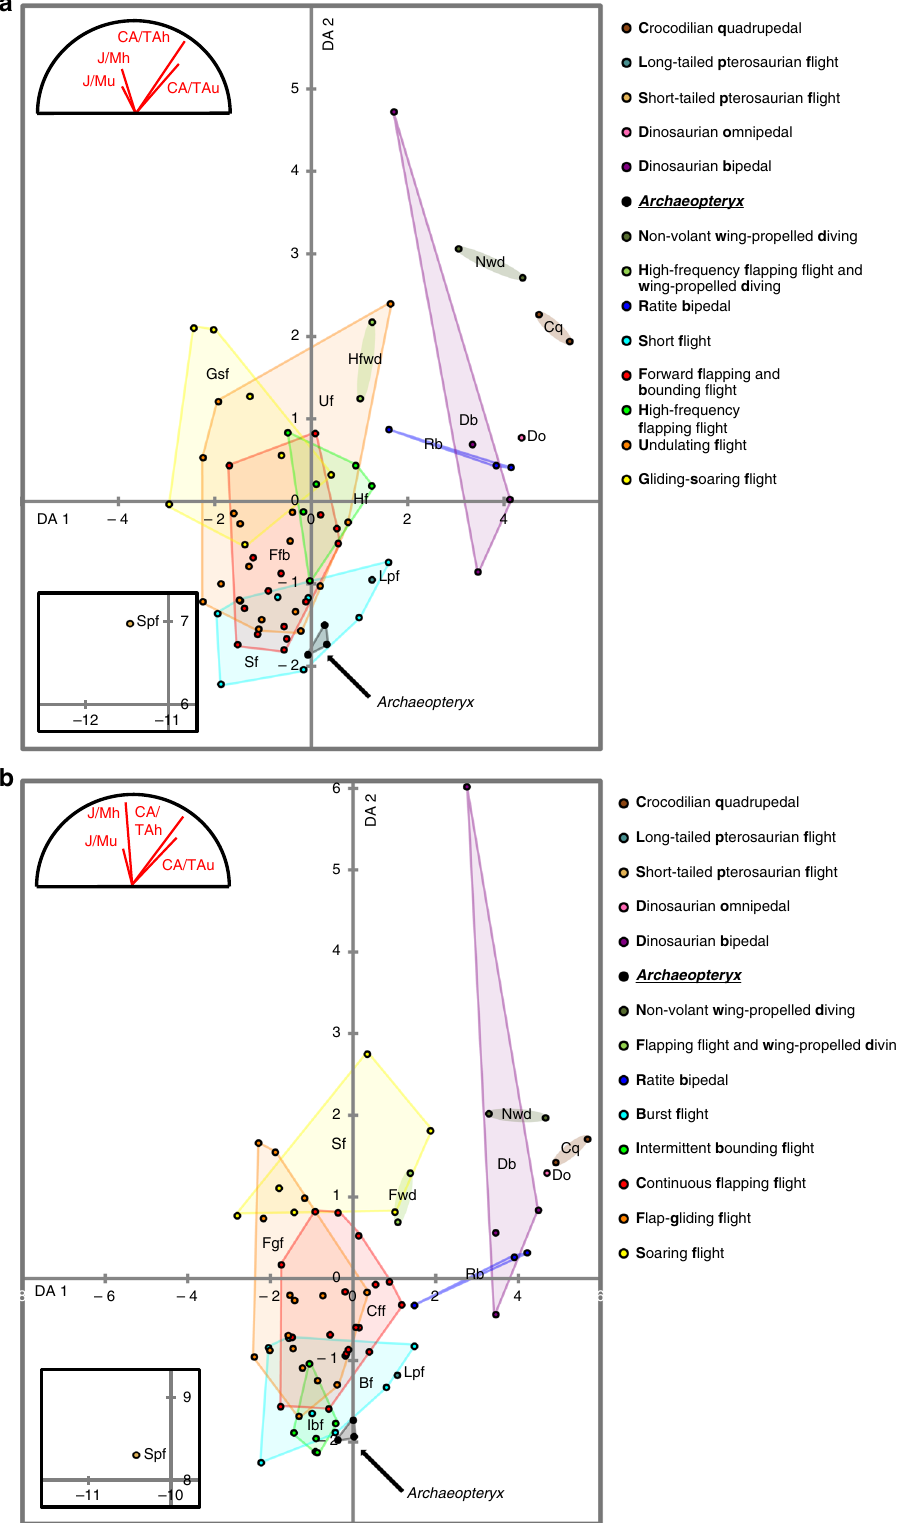
Fig. 2 LDA plot for speci fi c archosaurian humeral and ulnar CA/TA and J/M. First and second linear discriminant axes are presented. Classi fi cation follows the locomotory divisions adapted from a Viscor et al. 21 and b Close et al. 20 , non-pterosaurian fl ight strategies represent avian fl ight modes. Dots correspond to species, Archaeopteryx specimens plotted individually. Coloured hulls delimit groups with a minimum of three representatives; coloured ellipses link the members of groups with two representatives. Parameters labelled ¨_h¨ and ¨_u¨ in loading biplots designate humeral and ulnar af fi nity,